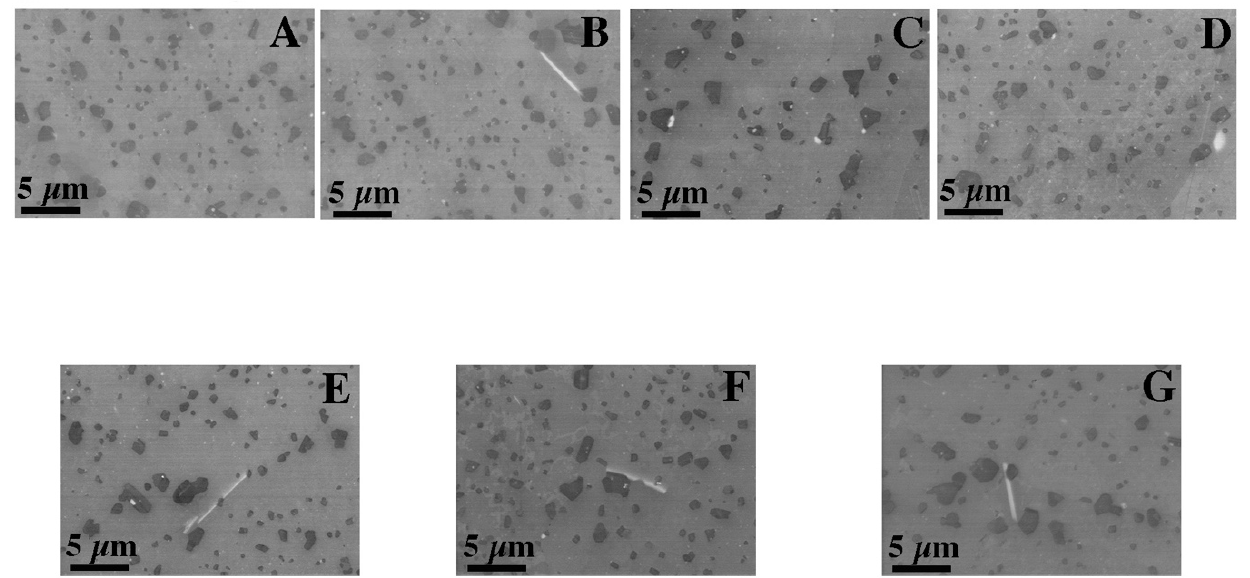
Figure 13. Microstructure of cast samples before and after heat treatment (SEM): ( A ) after DMLS, ( B ) after supersaturation, ( C ) after supersaturation and ageing—2 h, ( D ) after supersaturation and ageing—4 h, ( E ) after supersaturation and ageing—6 h, ( F ) after supersaturation and ageing—8 h and ( G ) after supersaturation and ageing—16 h.